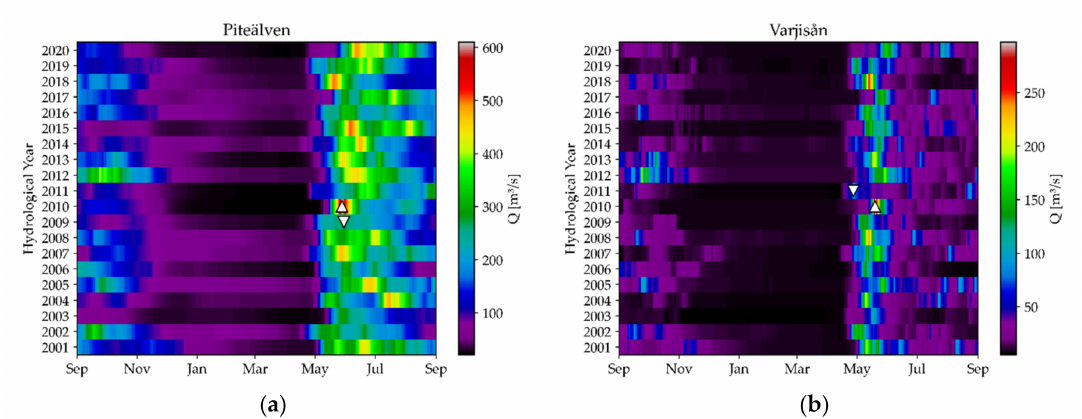
Figure 8. Discharge plots of ( a ) Piteälven and ( b ) Varjisån. The upward pointing triangle indicates the maximum spring flood, the downward pointing the